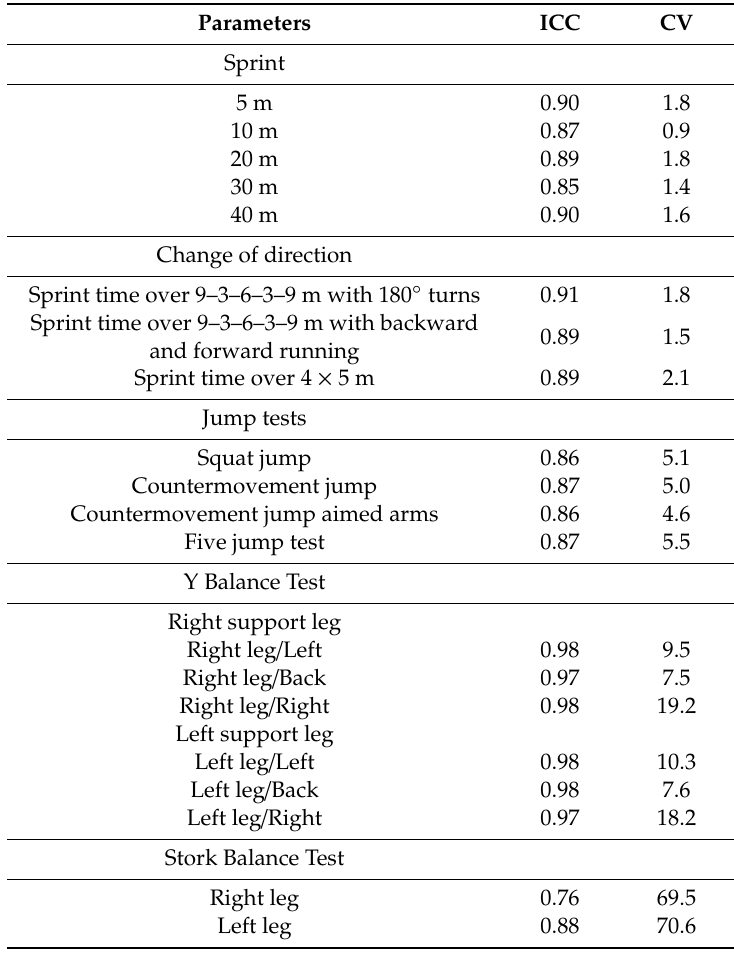
Table 3. Inter-class correlation coe ffi cient (ICC) and coe ffi cient of variation (CV), showing acceptable reliability for measures of track running velocity, change of direction, jump tests, static and dynamic balance tests. Parameters